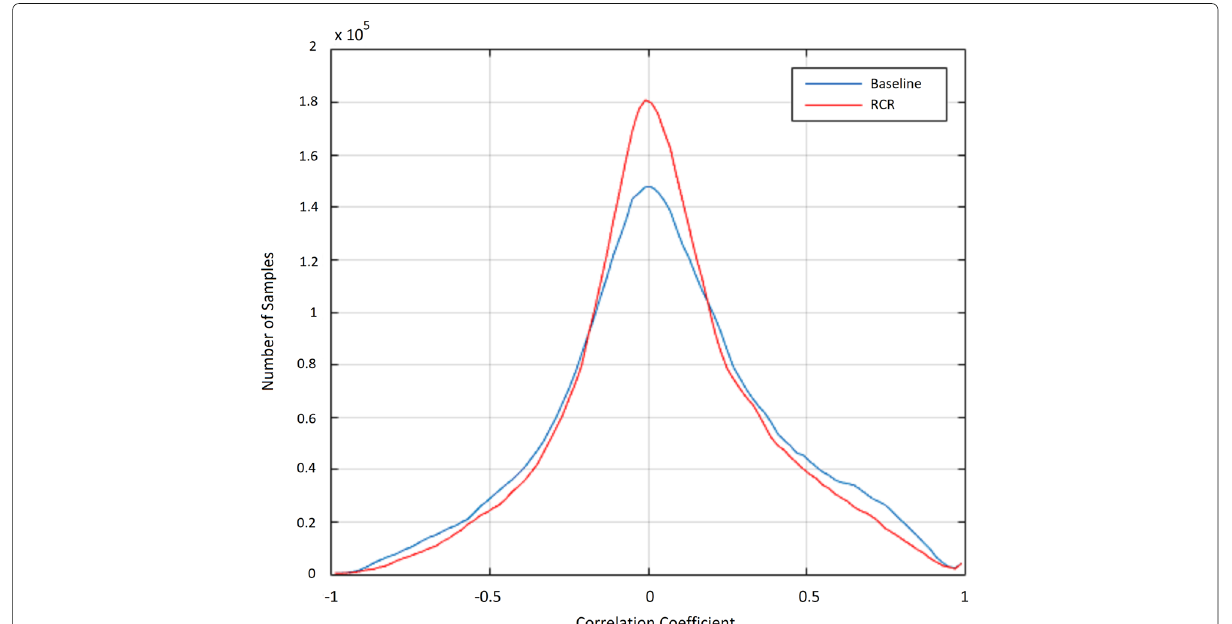
Fig. 4 Comparison of Pearson’s correlation coefficient distributions for the English database with (RCR algorithm) and without (baseline) using the unlabelled data for computing correlations